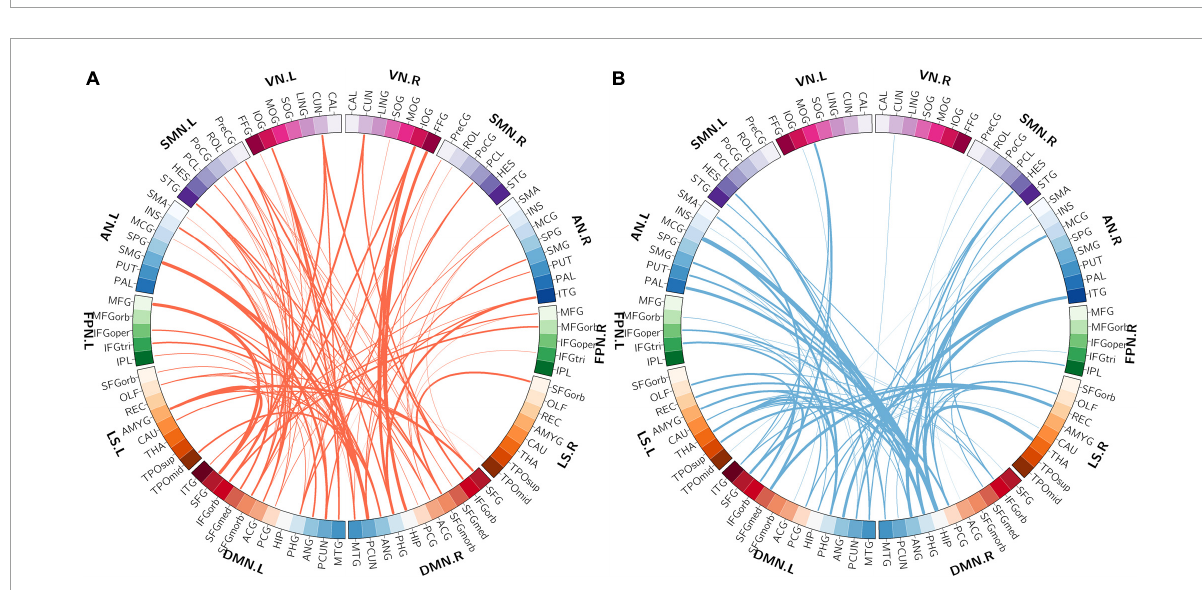
FIGURE6 The distribution of inter-network FCs between the DMN and the other five functional networks. (A) The spatial distribution of the selected inter-network FCs between DMN and the other networks with higher classification weights in patients with OSA compared with controls. (B) The spatial distribution of the selected inter-network FCs between DMN and the other networks with lower classification weights in patients with OSA compared with controls. The thickness of lines represents the absolute weight values. VN, visual network; SMN, somatomotor network; AN, attention network; FPN, frontoparietal network; DMN, default mode network; LS, limbic system.